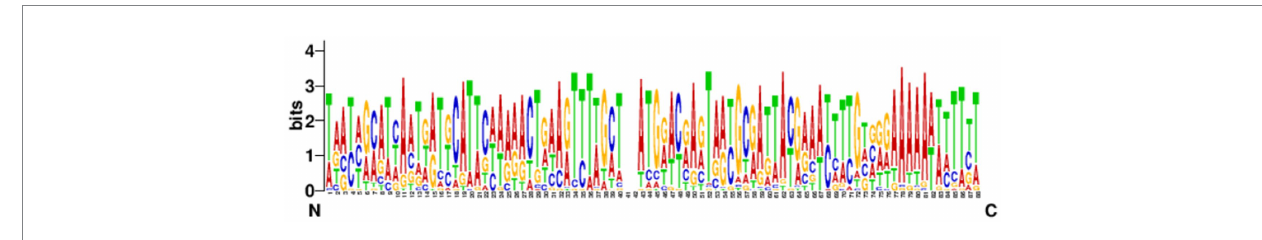
FIGURE 6 Analysis of the conservation of the leading sequences. The sequence identifier was created using WebLogo3, and the height of the letter indicates the relative frequency of the corresponding nucleotide at that